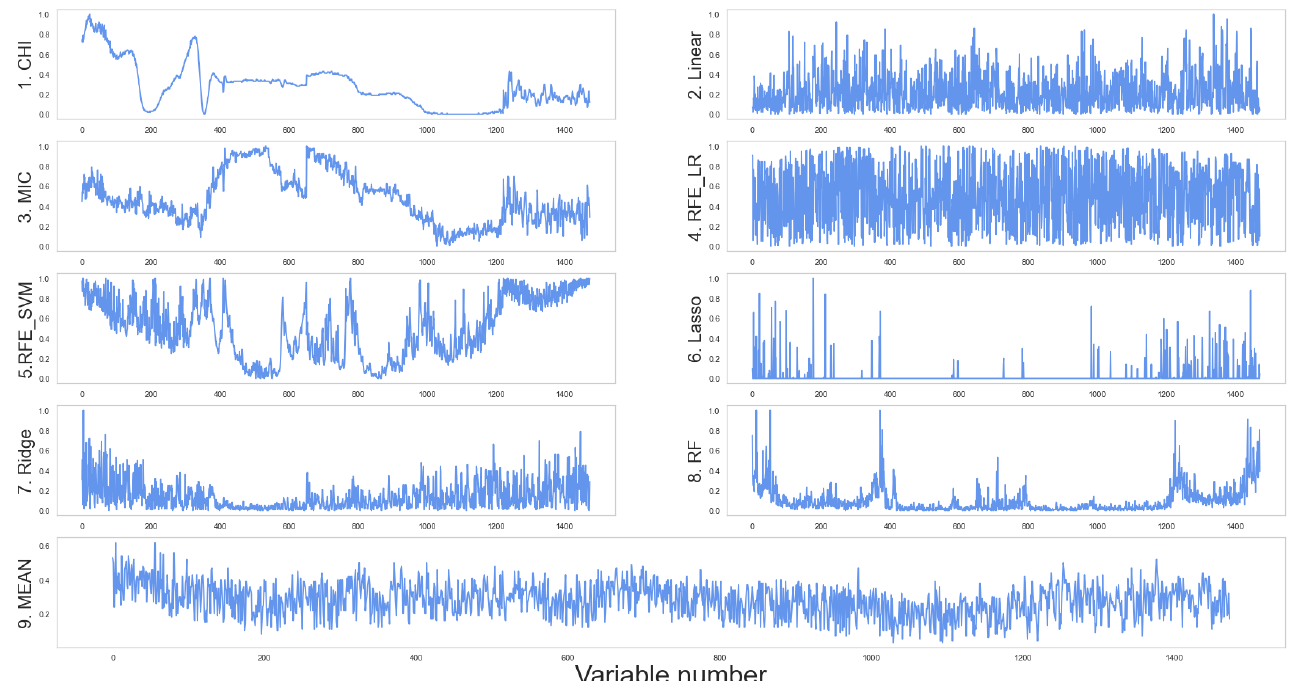
Figure 9. Results of feature scoring based on spectral data. The abscissa is the feature number and the ordinate is the score. MEAN shows the average value of all algorithms.